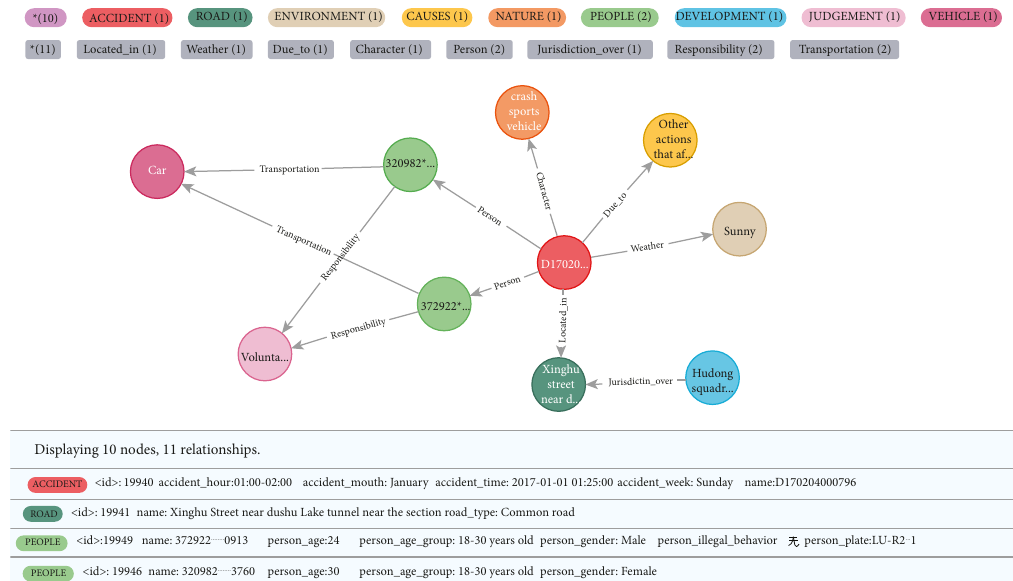
Figure 8: An accident portrait based on the traffic accident knowledge